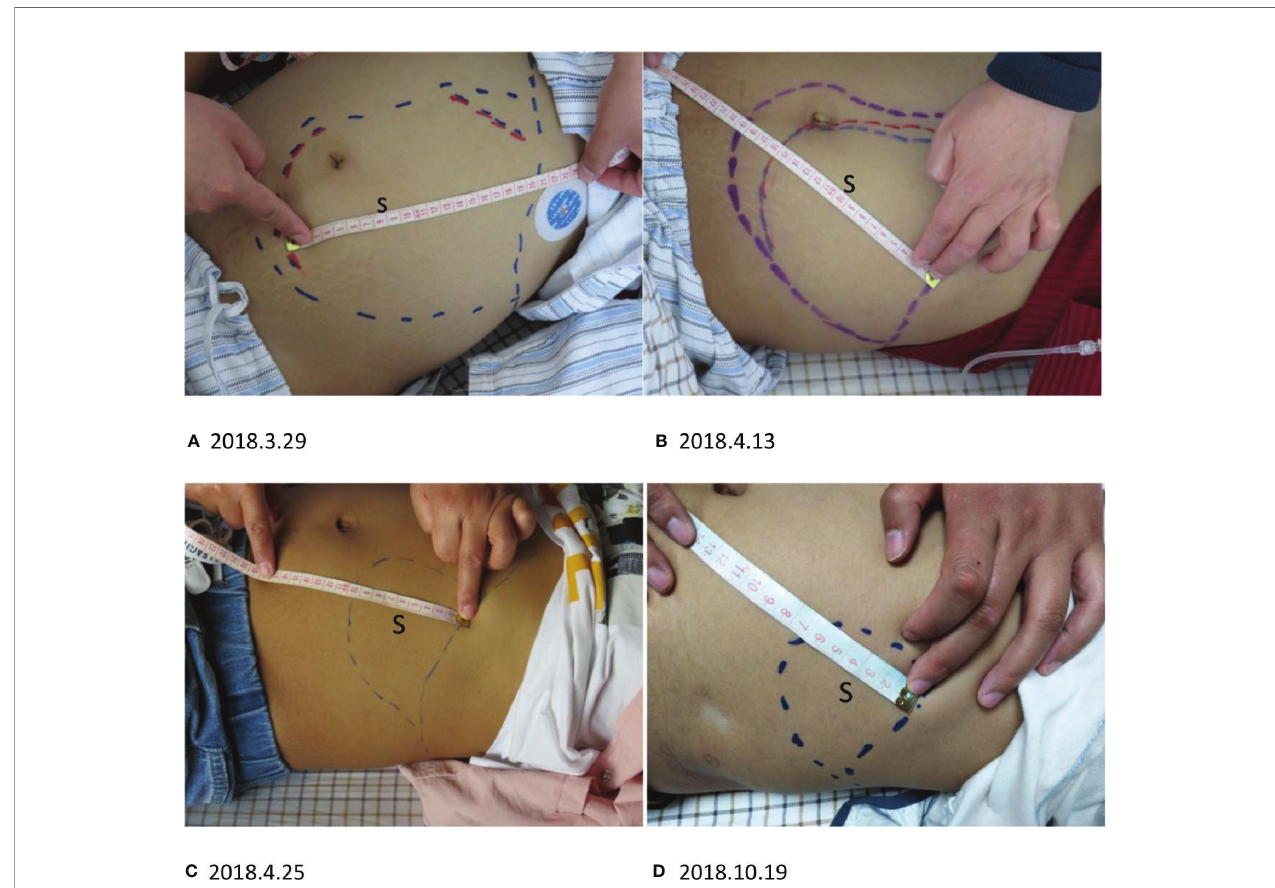
FIGURE 3 | S, splenomegaly. (A – C) The splenomegaly ameliorated quickly after CD19 CAR T-cell infusion. (A) The outermost blue line is the margin of splenomegaly before CD19 CAR T-cell treatment. The red line indicates the splenomegaly length after three days. (B) The splenomegaly shrank in approximately one month. The innermost blue line indicates the margin of the spleen two weeks after CAR T-cell infusion. (C) The splenomegaly continued to shrink before CD30 CAR T-cell infusion. (D) After CD30 CAR T-cell infusion, the splenomegaly continued to